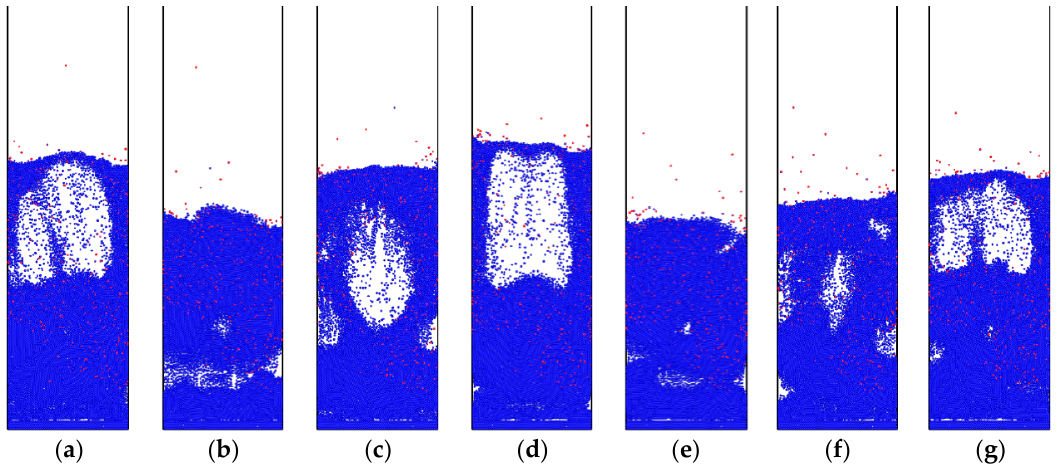
Figure 4. Particle distribution (blue: sand particles; red: biomass particles) ( a ) 9 s, ( b ) 9.1 s, ( c ) 9.2 s, ( d ) 9.3 s, ( e ) 9.4 s, ( f ) 9.5 s, and ( g ) 9.6 s. Energies 2020 , 13 , x FOR PEER REVIEW